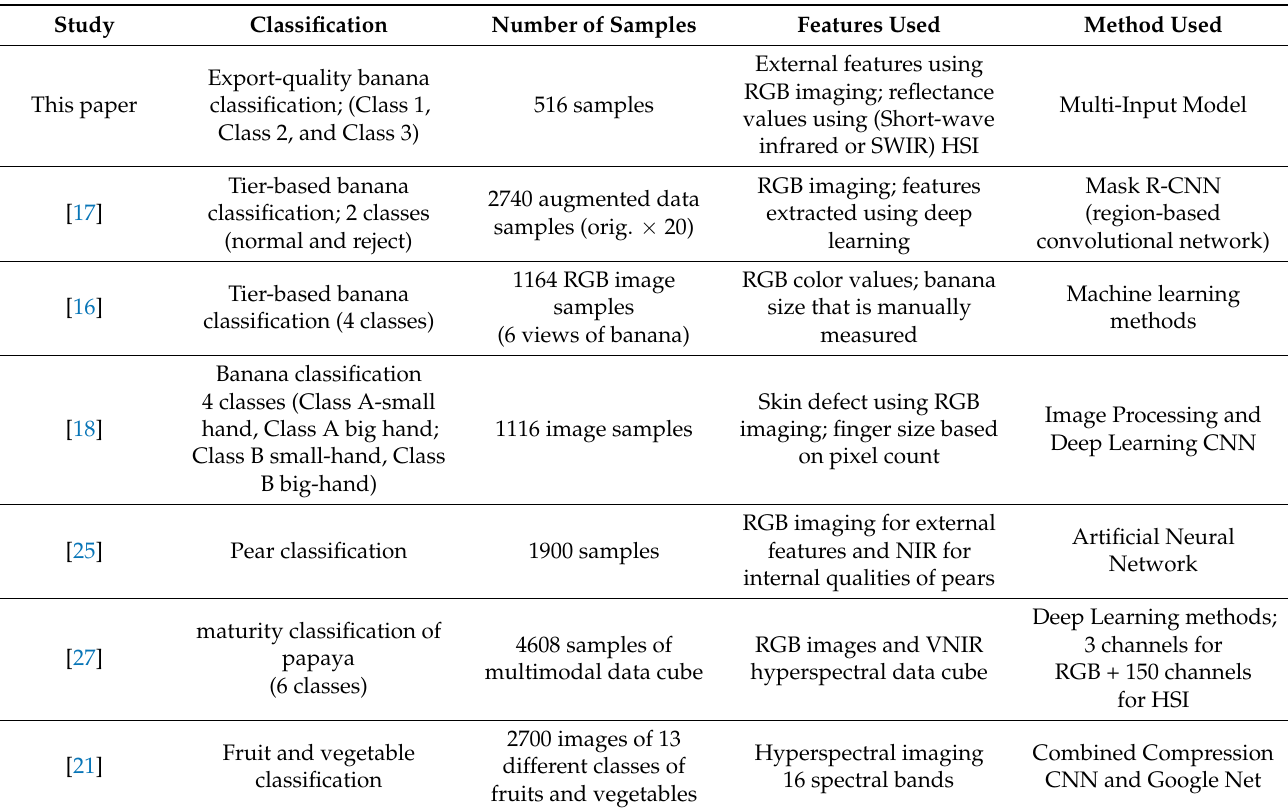
Table 1. Summary of different fruit classification methods reported in the